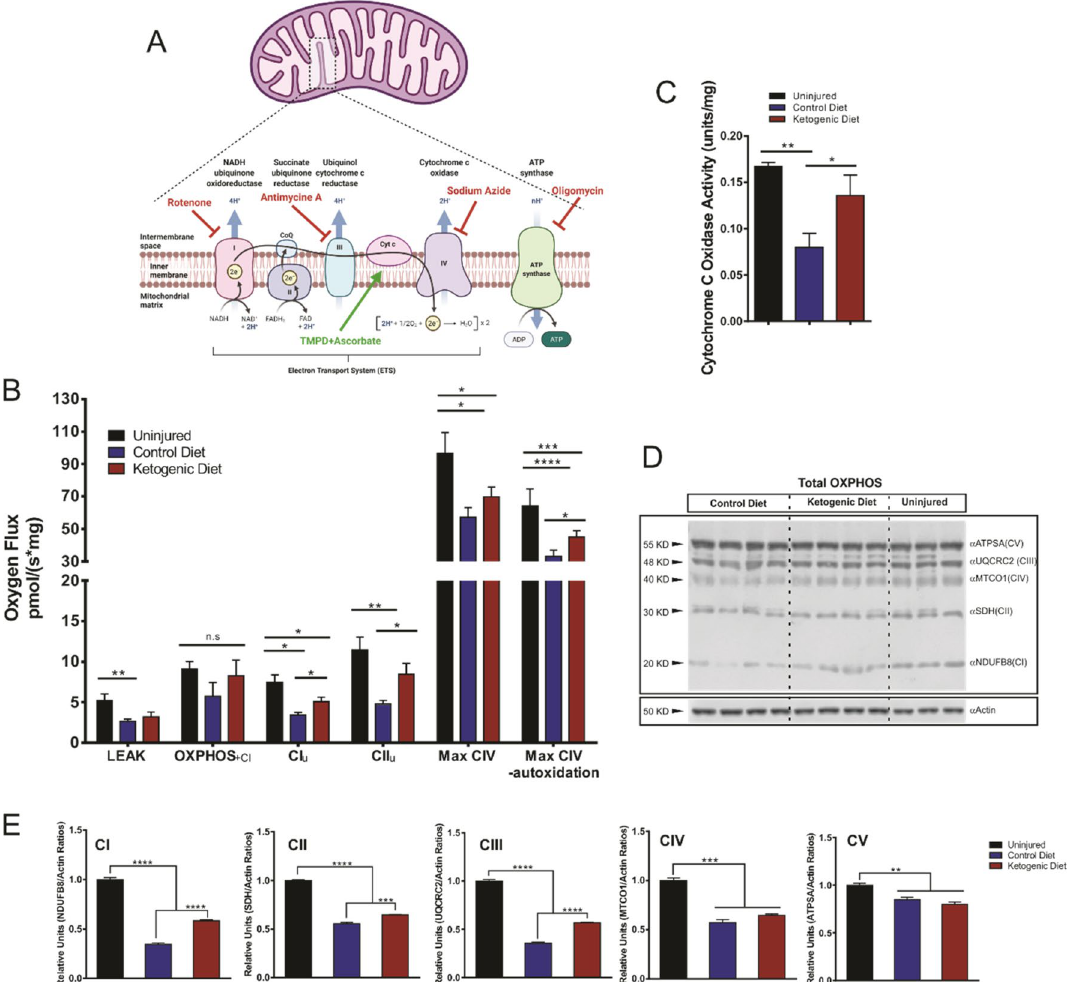
Figure 2. Mitochondrial respiration and western blotting analysis of the relative levels of the 5 OXPHOS complexes. ( A ) Schematic representation of the mitochondrial Electron Transport System (ETS). Adapted from “Electron Transport Chain”, by BioRender.com (2020). Retrieved from https:// app. biore nder. com/ biore nder- templ ates . ( B ) Quantification of mitochondrial respiration by high-resolution respirometry showing Oxygen flux values of the respiratory states. OXPHOS : Representing the maximum oxidative phosphorylation in the presence of metabolic substrates after the addition of ADP; LEAK respiration (proton leak) : Mitochondrial respiration rate in the presence of an ATP synthase inhibitor (Oligomycin); Complex I (CI) Maximum respiration : Maximum respiration measured after addition of the uncoupler carbonyl cyanide m-chlorophenyl hydrazone (CCCP) causing a depolarization of the cell membrane and leading to an increase in respiration; Complex II (CII) Maximum respiration : Maximum respiration measured after inhibition of CI with Rotenone and the subsequent addition of its substrate, Succinate; Complex IV (CIV) Maximum respiration : Maximum respiration estimated after inhibition of Complex III with Antimycin A, and the subsequent addition of ascorbate and N,N,N ′ ,N ′ - tetramethyl-p-phenylenediamine (TMPD) as proton donor substrates. Finally, NaN3 (Sodium Azide) was added to block the respiratory chain by blocking ATPase and leaving the fraction of total respiration that is non- mitochondrial, this value is subtracted from the Complex CV Maximum respiration in order to estimate the real mitochondrial CIV respiration . Student’s t-Student tests . ( C ) Cytochrome C Oxidase (or Complex IV) activity assay shows an increase in activity in the KD treated group. ( D , E ) Western blot of total OXPHOS proteins and subsequent quantifications showing an increase in the protein levels in CI, CII and CII after KD treatment versus the CD. One-way ANOVA, Tukey’s Post-hoc test. All data are mean ± control of the transcriptional and translational machineries in the injured spinal cord (Fig. 4). Using spinal cord homogenates, we first examined p44/42 MAPK (ERK1/2) and STAT3. Both kinases appear to play central roles in mitochondrial regulation and it has been suggested that they are translocated to the mitochondria and regulate the transcription of mtDNA 39,40 . Western blot analysis showed a significant decrease in phospho-p44/42 MAPK (ERK1/2) (Thr202/Tyr204) after SCI (56.6% decrease, p = 0.001) (Fig. 4a,b). The phosphorylation analy- sis of ERK1/2 revealed a significant increase in phosho-ERK1/2 in the KD group compared to the CD group (118.52% increase, p < 0.0001) (Fig. 4a,b). A significant increase in total STAT3 expression was observed in the